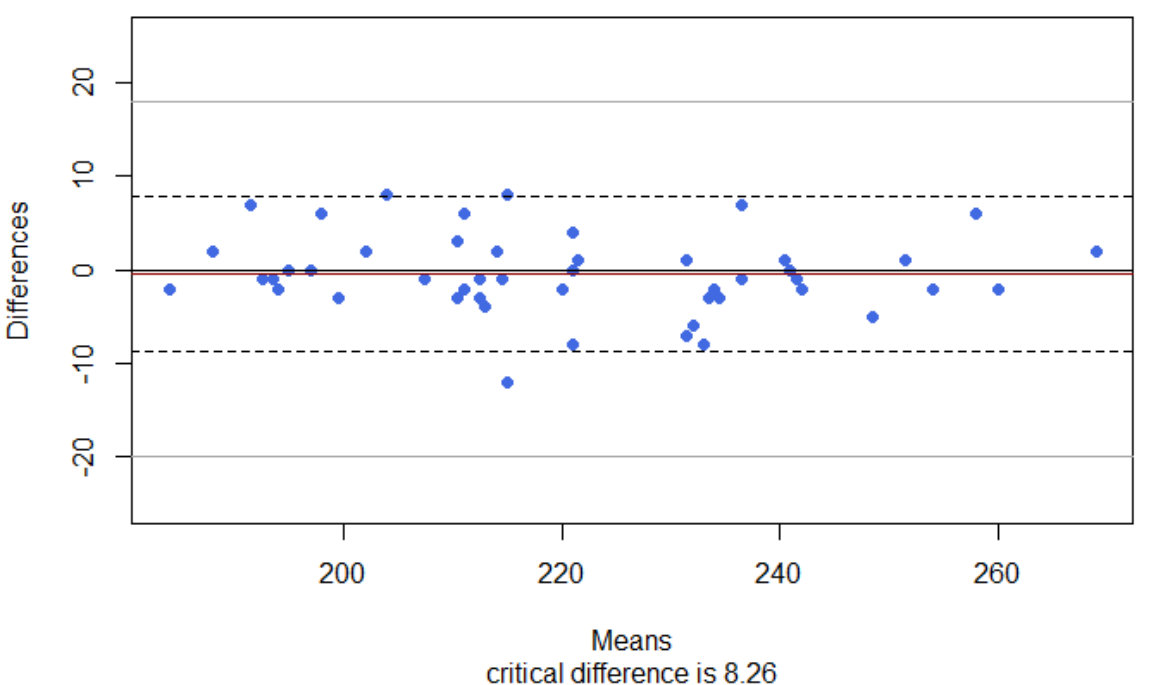
Figure 1. Bland-Altman plot of the difference between the gold standard daily steps and the wearable device measured daily steps (intraclass correlation coefficient .98, 95% CI 0.96-0.99). The red line indicates the mean difference (–0.4). The dotted lines indicate the Bland limit of agreement 1.96=*SD. The dark grey lines indicate a reasonable limit of agreement (-20; 18) as indicated in a study conducted to validate a Fitbit wearable device on an elderly population [31].